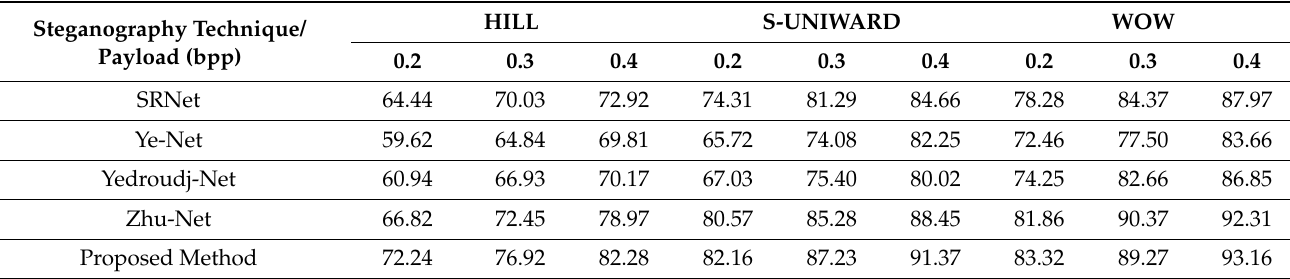
Table 6. Performance assessment while considering Case